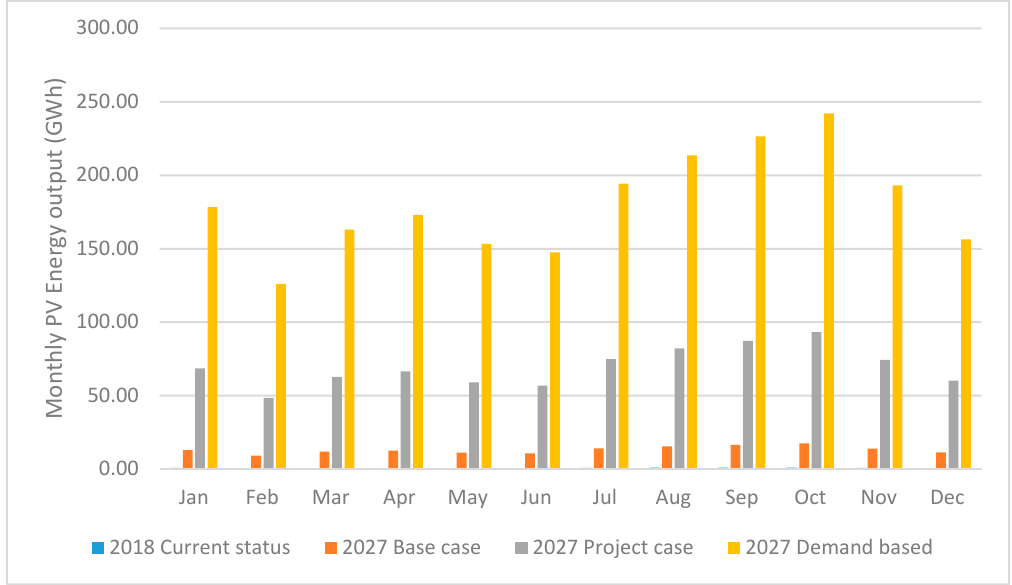
Figure 10. Forecast of the monthly PV electricity generation for 2018 and 2027 according to the 3 scenarios.